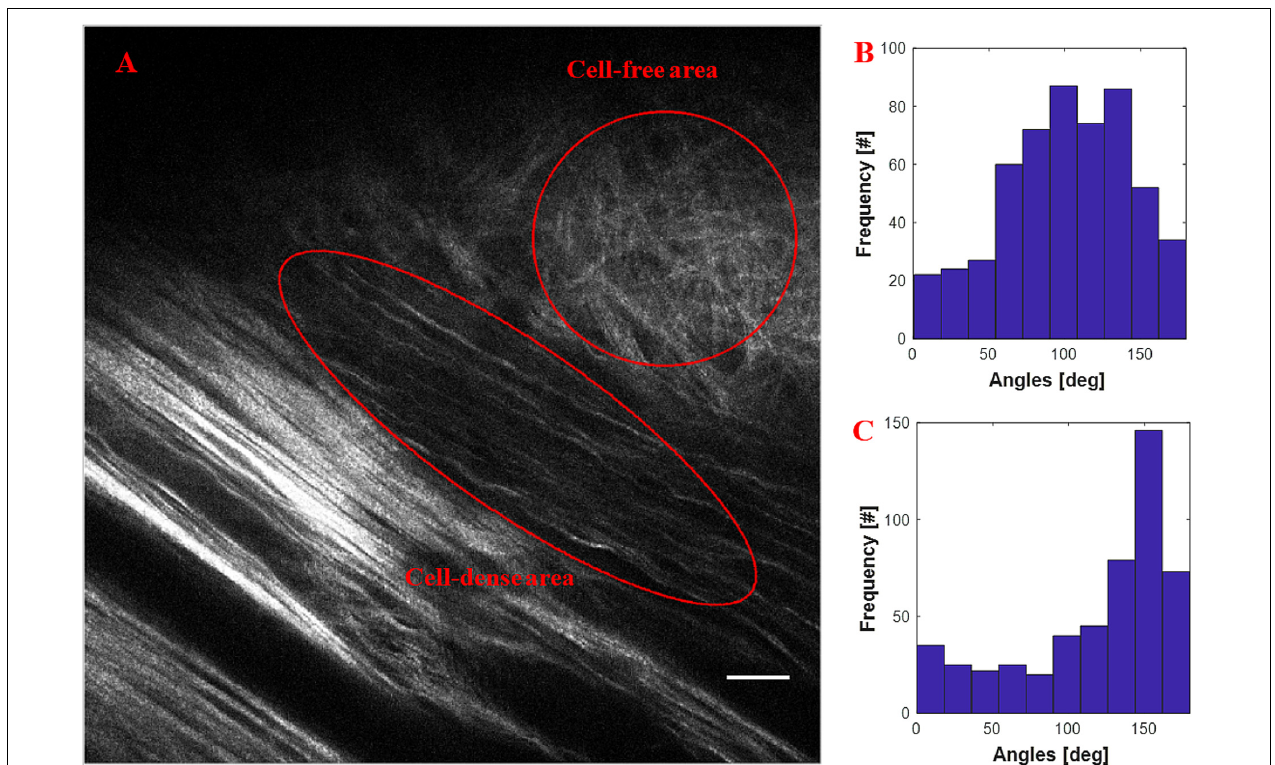
FIGURE 4 | An example of quantification of invading cells reorganizing the ECM of an adult mouse implanted with xenograft of MDA-231 breast cancer cells for 3 weeks. (A) SHG image showing the boundary of tumor cell/collagen. (B) Histogram of fiber angles in the cell-free area of collagen. (C) Histogram of fiber angles in the cell-dense area of collagen. The histograms indicate that the collagen fibers are more aligned in the cell-dense area than the fibers in the cell-free area. Scale bar equals 25